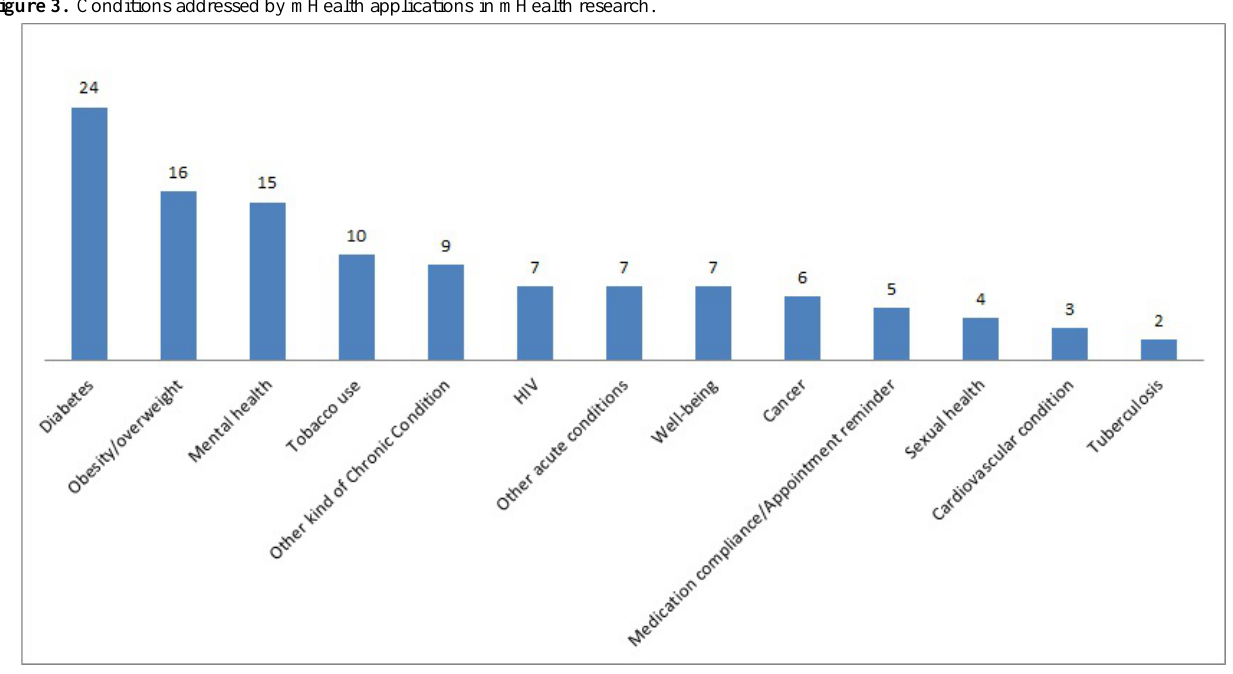
Figure 3. Conditions addressed by mHealth applications in mHealth